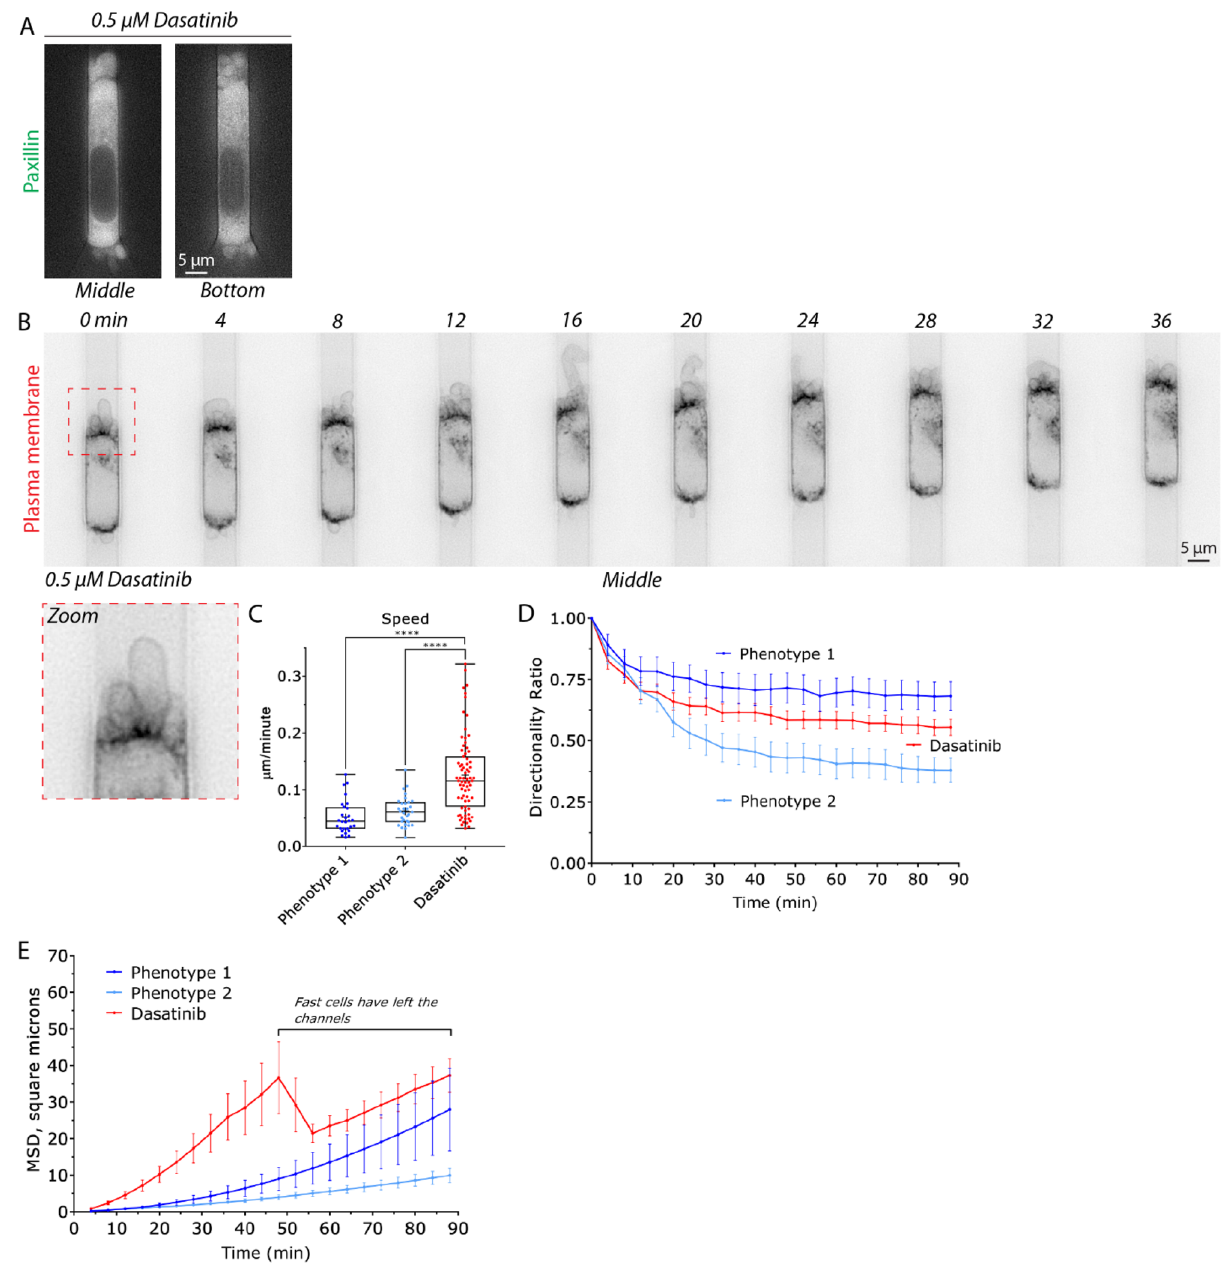
Figure 3. Pharmacologically inhibiting focal adhesion formation increases the speed and directionality of blebbing cells. ( A ) Confirmation that a melanoma A375-M2 cell with the focal adhesion marker, EGFP- paxillin, within a fibronectin coated (10 µg/mL) microchannel does not form focal adhesions after treatment with Dasatinib (0.5 µM). Middle (left) and bottom (right) focal planes are shown. ( B ) Montage of a melanoma A375-M2 cell treated with Src family kinase inhibitor, Dasatinib (0.5 µM). Cells were visualized using a far red membrane dye. Zoom shows prominent blebs at the cell leading edge. ( C ) A comparison of instantaneous speeds for phenotype 1 (N = 28), 2 (N = 31), and Dasatinib (N = 75) treated cells. Statistical significance was determined by a Dunn’s multiple-comparison test post-hoc. ( D ) A comparison of directionality ratio over time for phenotype 1 (N = 28), 2 (N = 31), and Dasatinib (N = 75) treated cells. Error is SEM. ( E ) A comparison of Mean Square Displacement (MSD; square microns) over time for phenotype 1 (N = 28), 2 (N = 31), and Dasatinib (N = 75) treated cells. As noted on the right of the graph, a sharp decrease in the graph is the result of fast cells leaving the channels. All data are representative of at least three independent experiments. *— p ≤ 0.05, **— p ≤ 0.01, ***— p ≤ 0.001, and ****— p ≤